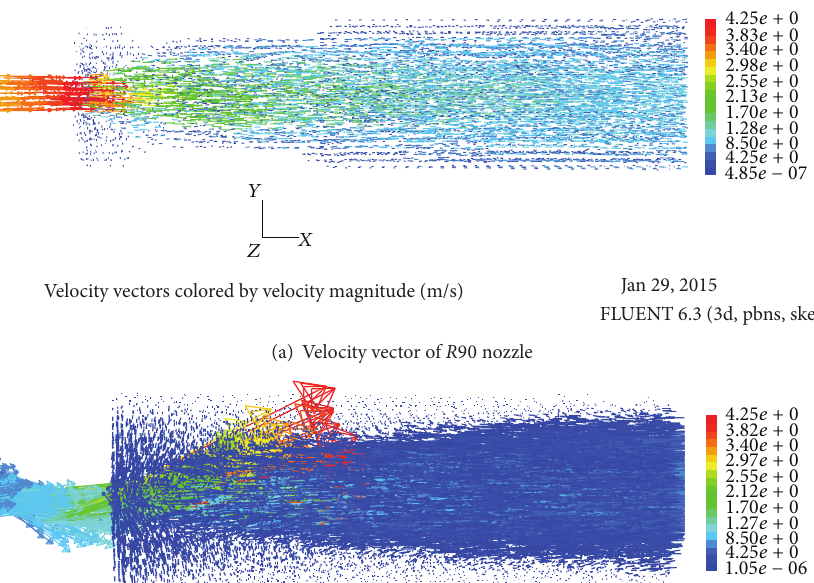
Figure 10: Velocity vectors of helix nozzle.